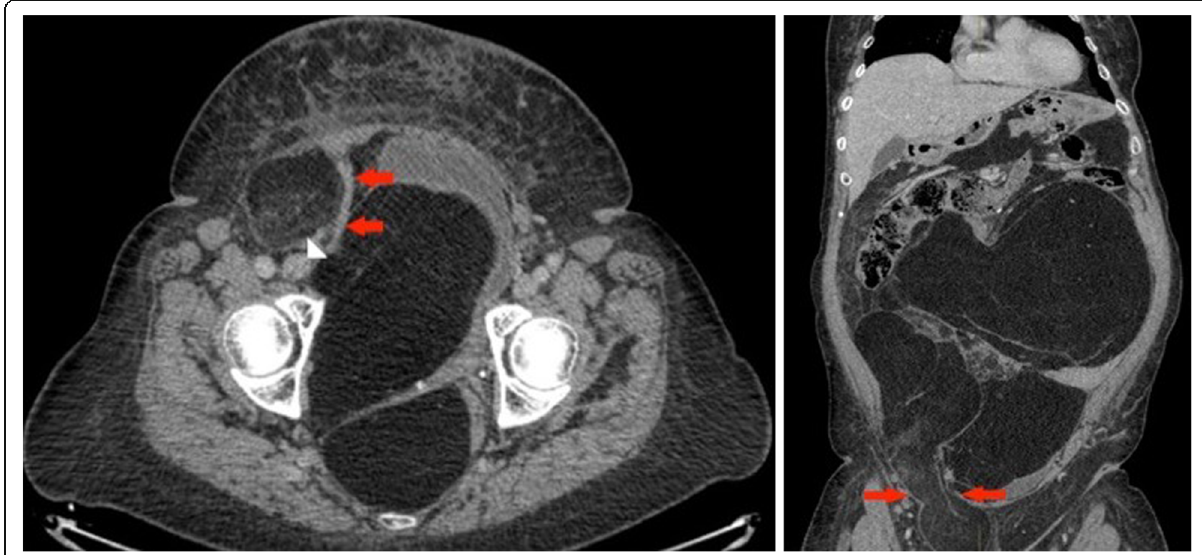
Fig. 2 Left panel: Axial non-contrast-enhanced CT: a large pelvic mass predominantly of fat density is seen to compress and displace the bladder anteriorly. Part of the mass also extends into the right groin lateral to the epigastric vessels which are stretched over the lesion medially (red arrows). The white arrowhead points towards the origin of the inferior epigastric vessels from the external iliac vessels. Right panel: Coronal reconstruction of a non-contrast-enhanced CT, demonstrating the hernial neck (red arrows) as the tumour extends into the right inguinal